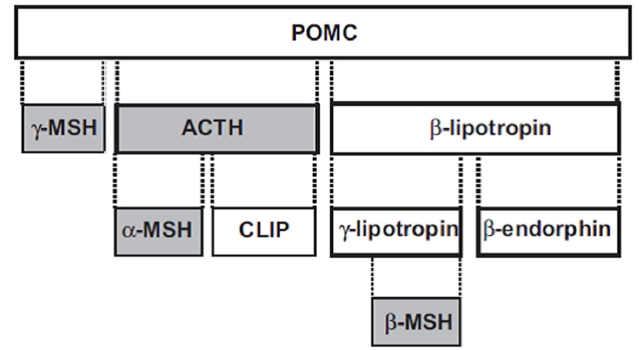
Figure 1. Melanocortin peptides (shaded boxes) derived from POMC. ACTH: adrenocorticotropic hormone; CLIP: corticotropin-like intermediate lobe peptide; MSH: melanocyte-stimulating hormone; POMC: proopiomelanocortin, Reprinted by permission from [8].